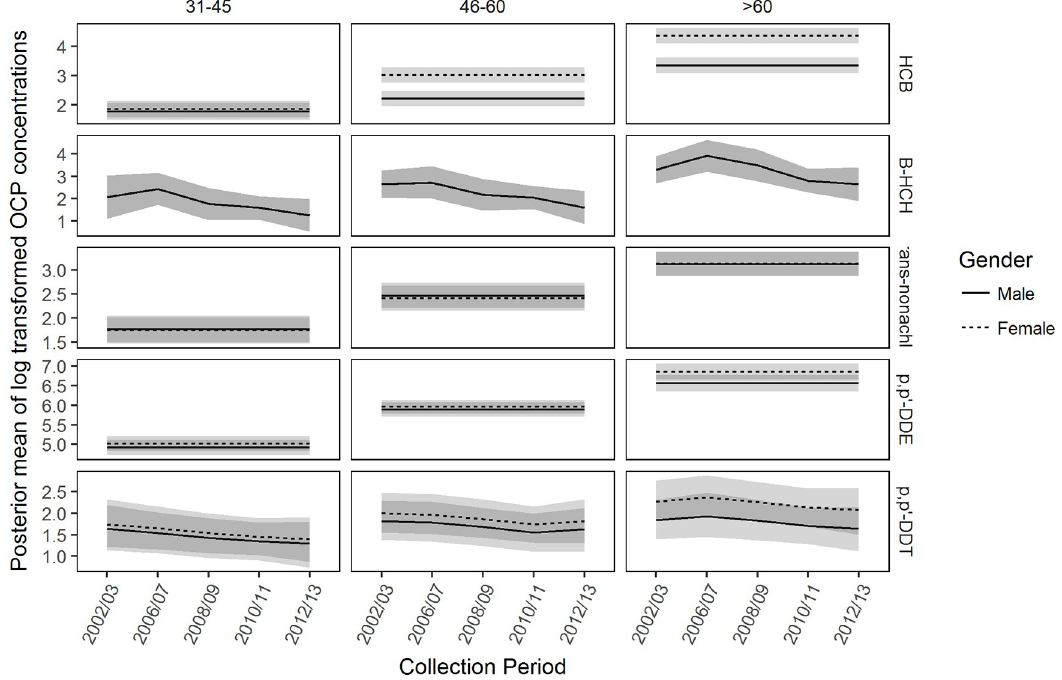
Fig 5. Posterior mean OCP concentrations. Posterior mean log-transformed concentrations of HCB, β -HCH, Trans-nonachlor, p, p’ -DDE and p,p’ -DDT plotted over the years 2002/03 to 2012/13 for age groups 31-45, 46-60 and > 60 year olds. HCB, Trans- nonachlor and p,p ’-DDE were specified by Model 2, p,p ’-DDT by Model 3 and β -HCH by Model 1. Line type indicates the gender, as described in the figure legend. The light grey bands around the posterior means indicate the 95% credible interval and the dark grey bands indicate an overlap of the 95% credible intervals where there is not enough evidence for the OCP concentration. Units of OCP concentrations were in ng/g